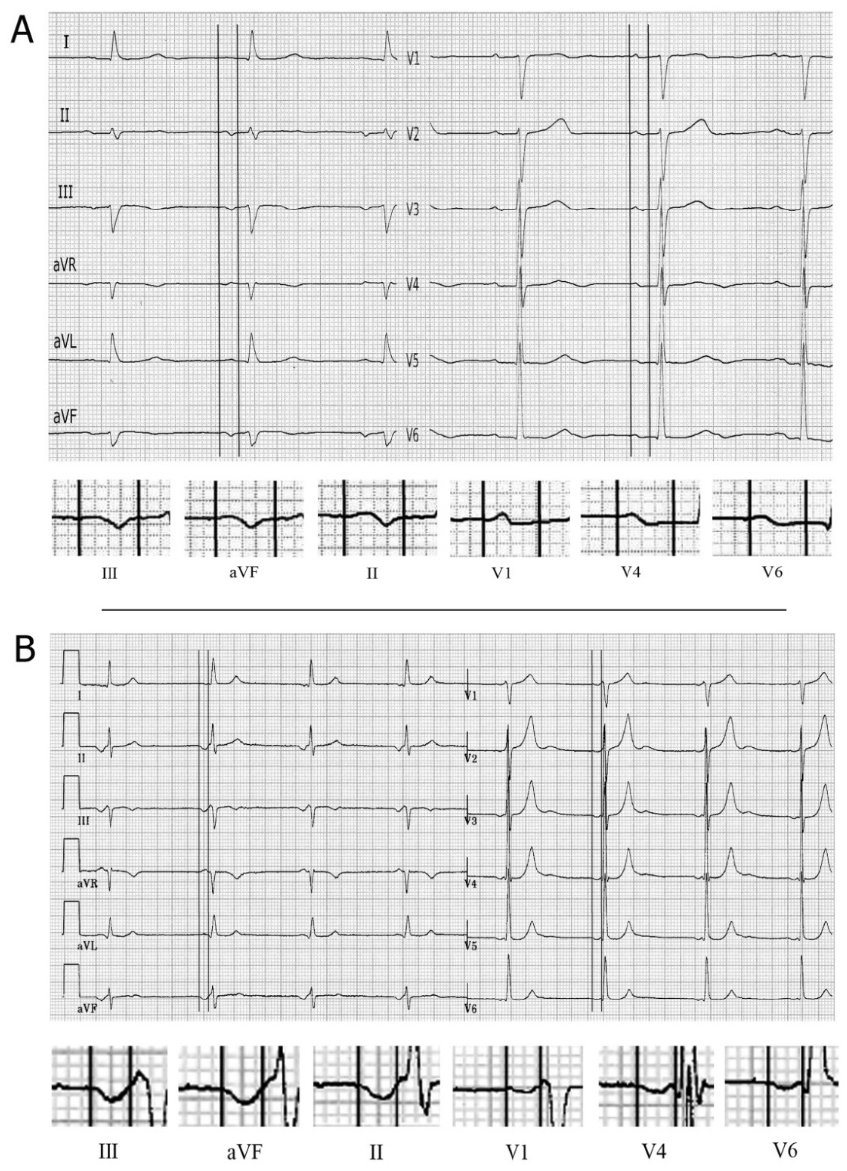
Figure 10. ( A ) P-wave in a case of A-IAB atypical type 3 by morphology. Note that the P-wave is negative in III and aVF, but with a first part isodiphasic as may be seen with vertical lines. It may be confused with junctional rhythm, but in this case (see B ) all the P-wave is negative and, furthermore, the P-wave is also negative in V4–V6. (Taken from reference 37).